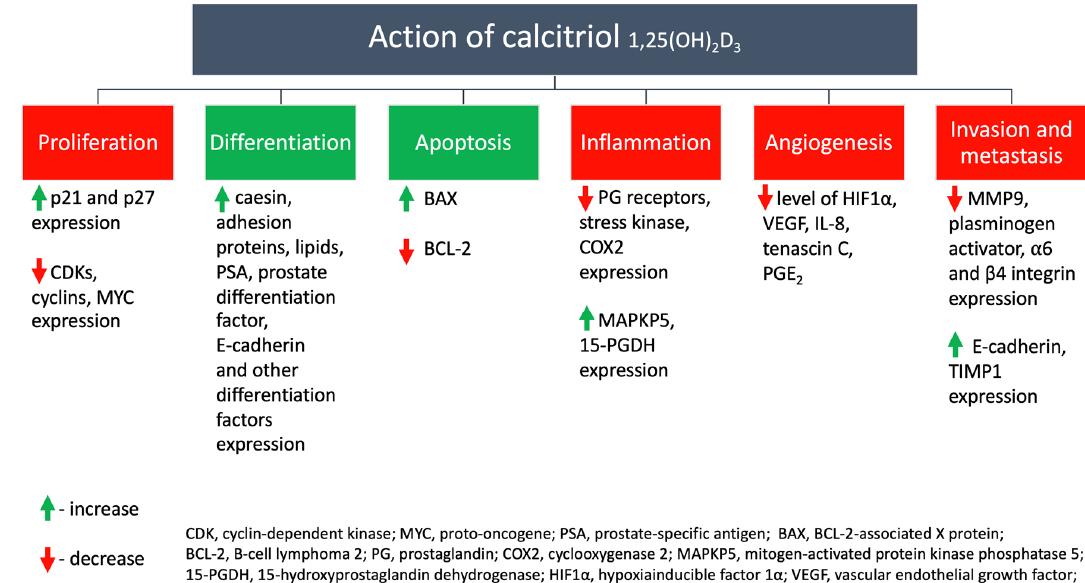
Figure 1. The di ff erent e ff ects of calcitriol (the bio-active form of vitamin D) on the human body (based Figure 1. The different effects of calcitriol (the bio-active form of vitamin D) on the human body (based on Feldman et al. 2014 [1], with own on Feldman et al. 2014 [1], with own modifications).